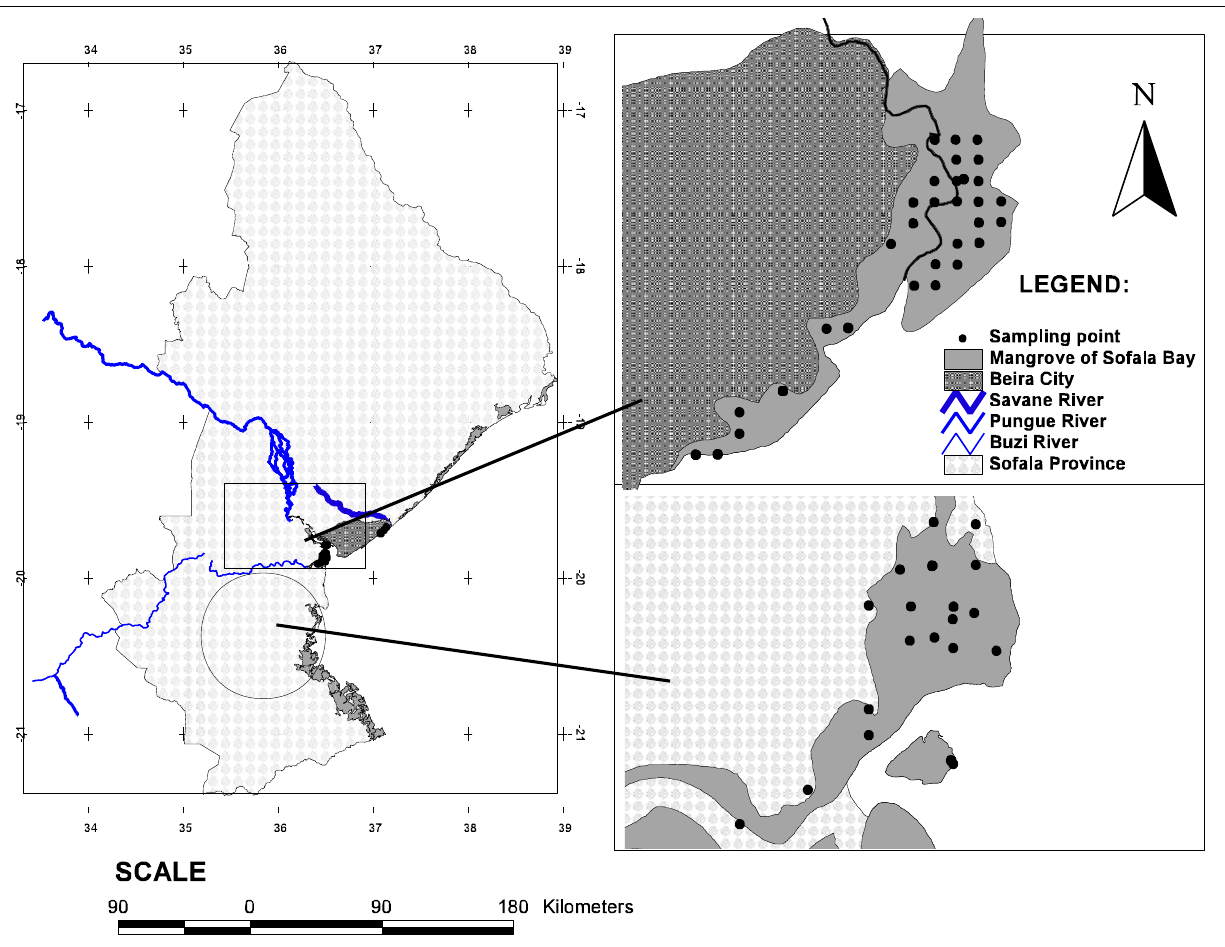
Figure 1. Location of the study site and sampling points in the mangrove of Sofala